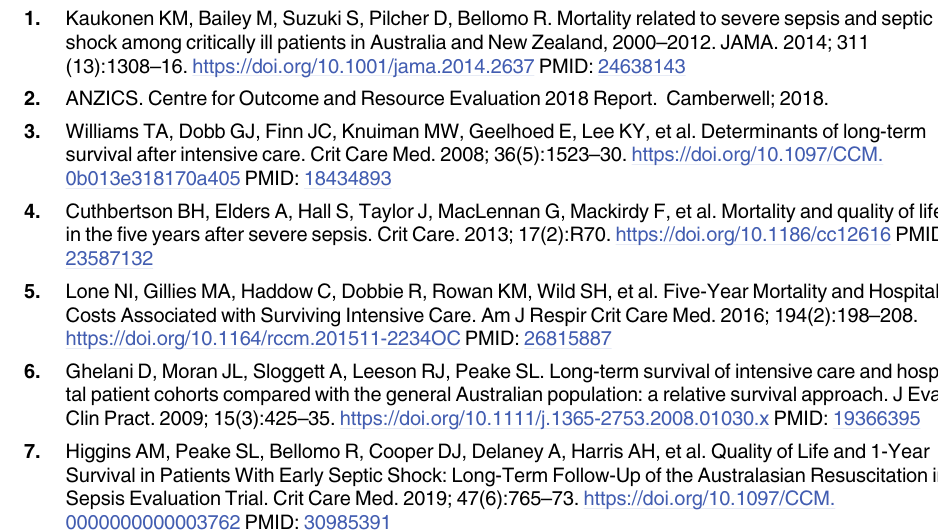
S1 Table. Comparison of characteristics between patients linked to the VAED and those not able to be linked. The unlinked cohort had the same inclusion criteria applied to it as the linked cohort. Variables that appeared in the Table 1 of the main manuscript that are absent from this table were those not included in both datasets. IQR; Interquartile range, Index of Rel- ative Socioeconomic Advantage and Disadvantage, ICU; Intensive Care Unit, ED; Emergency Department, LOS; Length of stay, APACHE; Acute Physiological and Chronic Health Evalua- tion, COPD; Chronic Obstructive Pulmonary Disease, GI;